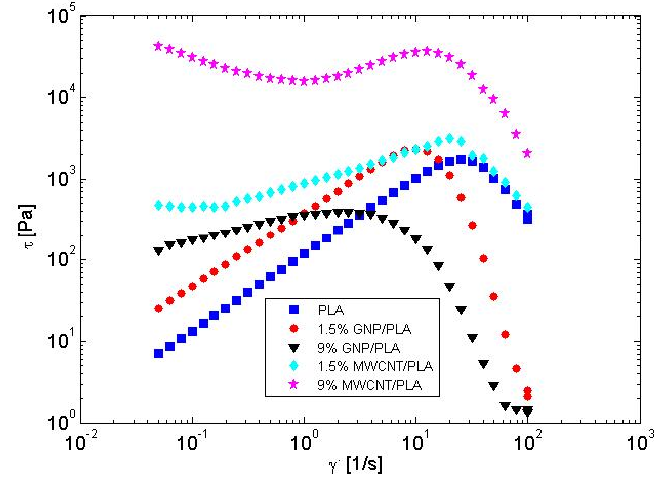
Figure 4. Experimental data for the shear stress as a function of the shear rate.